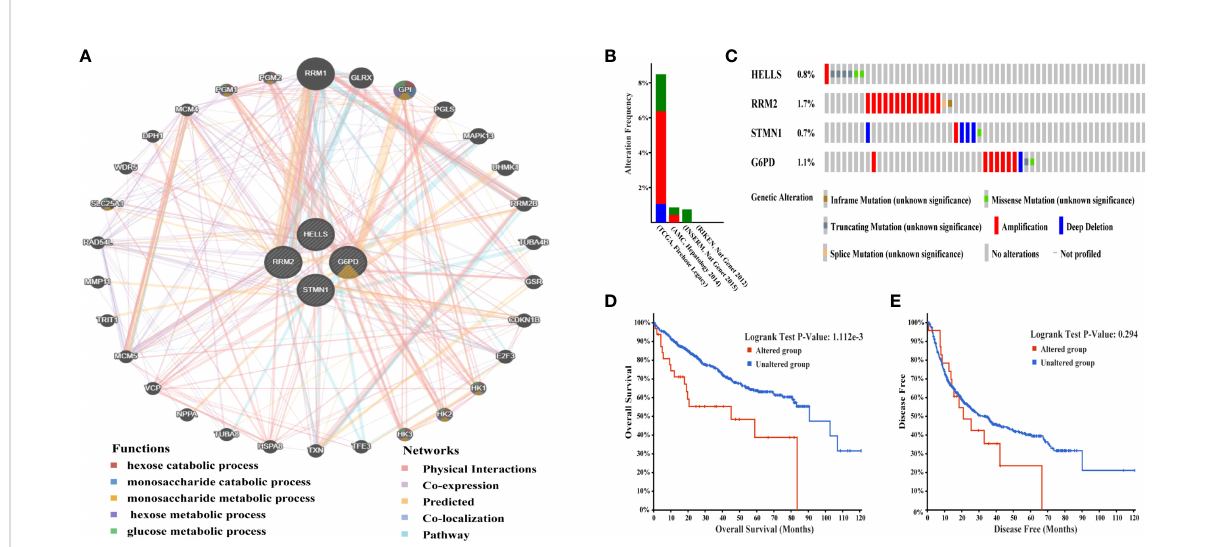
FIGURE 3 Interaction network and genetic alterations of four hub FRGs in HCC. (A) The gene-gene interaction network of four hub FRGs and 30 neighboring genes was constructed. (B) Alterations of the four FRGs in six datasets: (Liver Hepatocellular carcinoma, TCGA, Firehose Legacy; Liver Hepatocellular carcinoma, RIKEN, Nat Genet 2012; Liver Hepatocellular carcinoma, AMC, Hepatology 2014; Liver Hepatocellular Adenoma and Carcinomas, MSK, PLOS One 2018; Hepatocellular carcinomas, INSERM, Nat Genet 2015; Hepatocellular carcinomas, MSK, Clin Cancer Res 2018). (C) Alteration frequencies of 4 FRGs were based on the six datasets described earlier. (D) Kaplan-Meier plots comparing OS in cases with and without alterations 4 FRGs alterations. (E) Kaplan-Meier plots comparing DFS in cases with and without alterations 4 FRGs